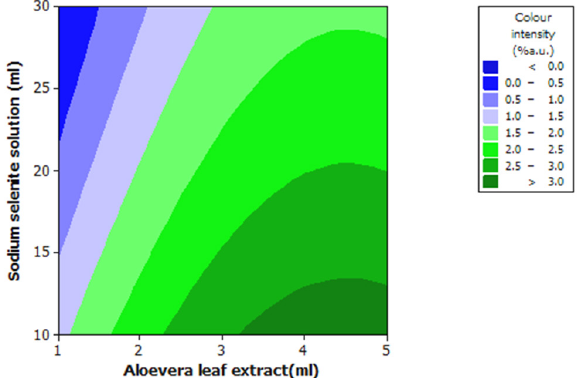
Figure 4: Contour plot of particle size of the solution containing Se NPs as function of amount of Na